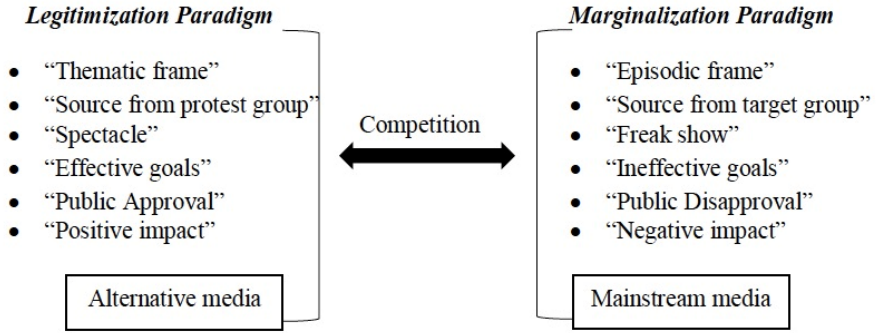
Figure 3. Legitimization paradigm adopted by the alternative media.